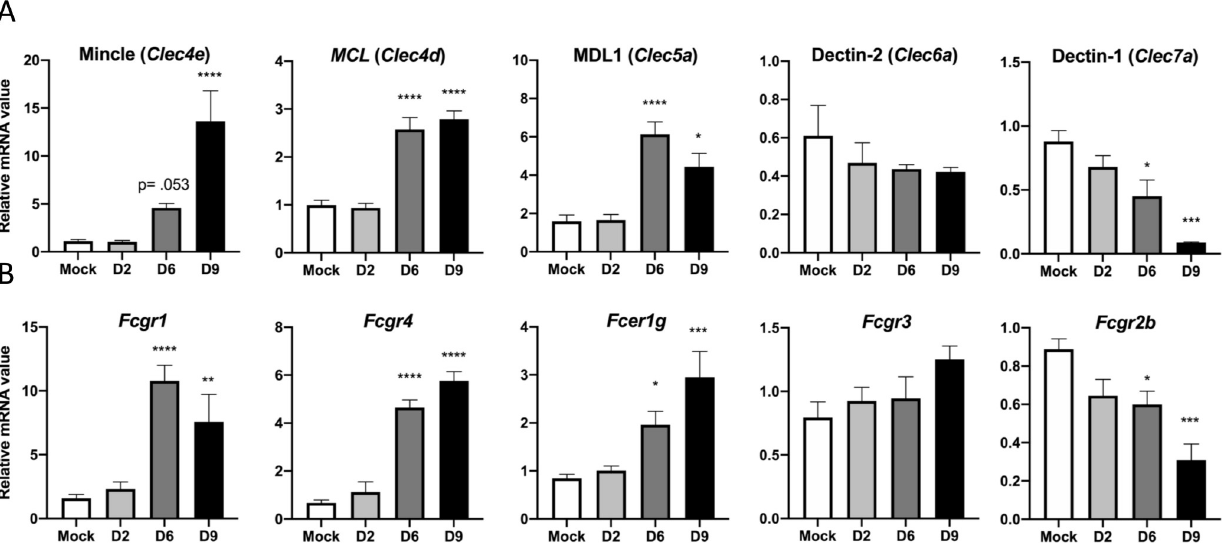
Fig 3. Mincle is the most predominant CLR expressed in infected lungs. qRT-PCR detection of (A) indicated CLRs and (B) Fcgr subtypes in whole lung tissue homogenates of lethally infected mice. Shown are representative data from 3 independent mouse infection experiments with similar trends. Data are presented relative to GAPDH values and shown as mean ± SEM. One-way ANOVA with Dunnett’s multiple comparison test was used for statistical analysis, with Mock samples used as a reference. � , p < 0.05; �� , p < 0.01; ��� , p < 0.001; ���� , p <